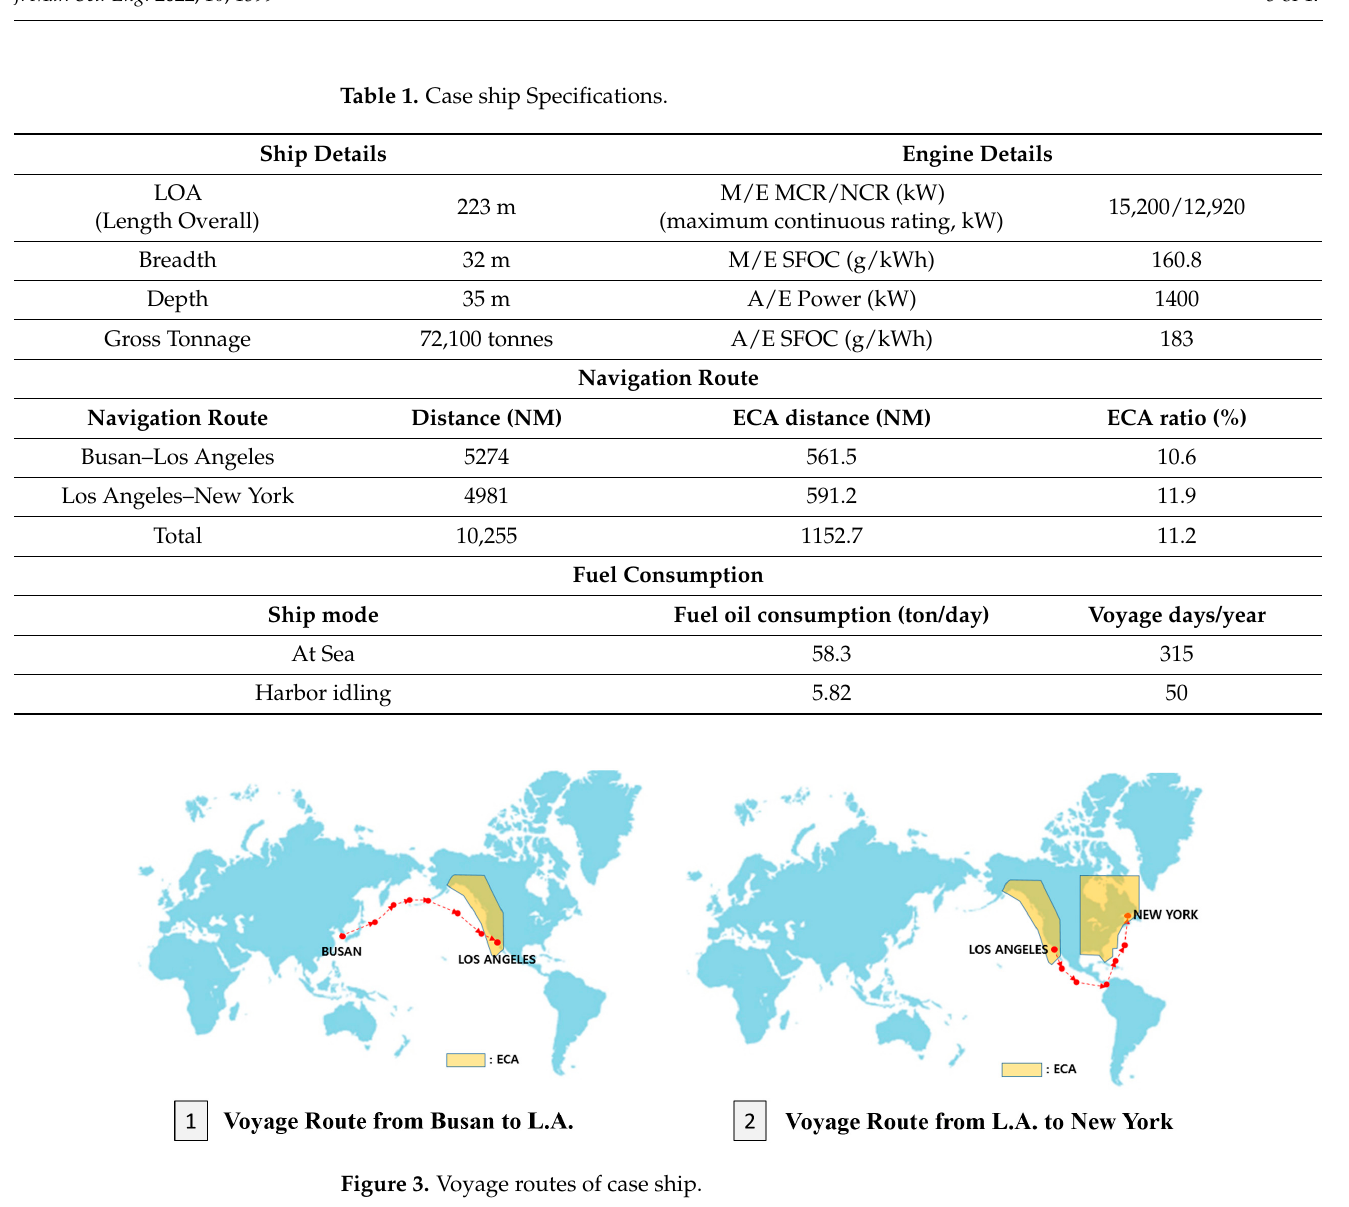
5 of 19 Table 1. Case ship Specifications. Ship Details